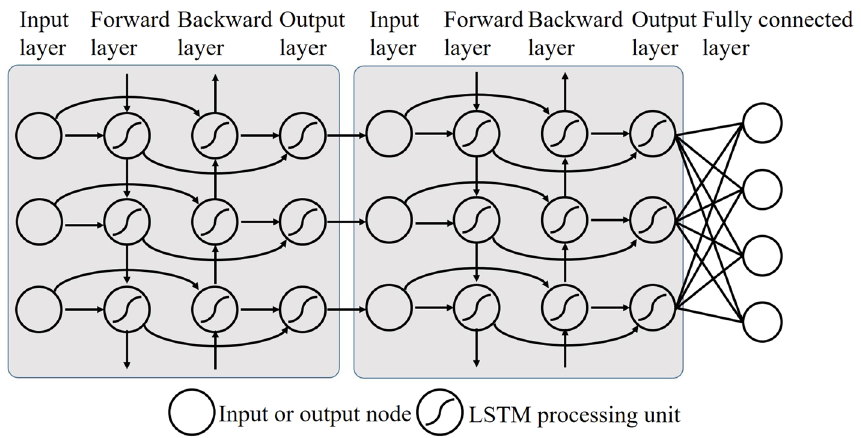
Figure 5. Diagram of two-layer BiLSTM we used. Each circle represents a node, the input layer has three nodes and the output layer has four nodes. The direction arrow indicates the direction of information flow.